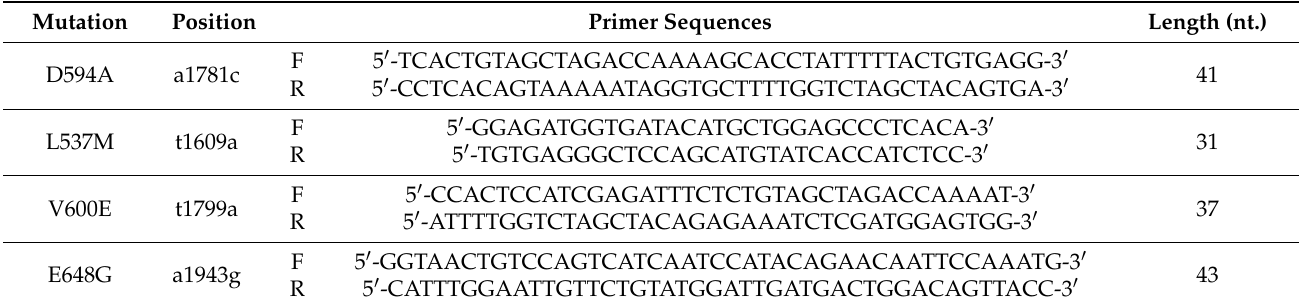
Table 4. Sequences of the primers used for site-directed mutagenesis. Primer Sequences Length